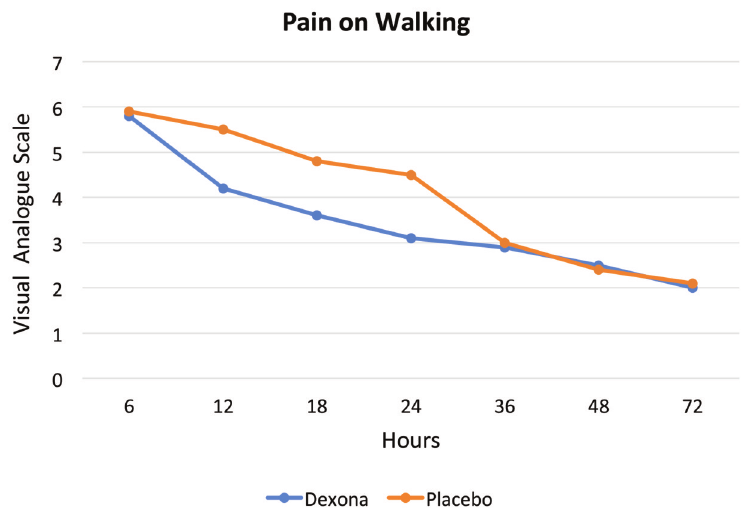
Level of pain while walking within 72 hours of anterior cruciate ligament Fig. 3: